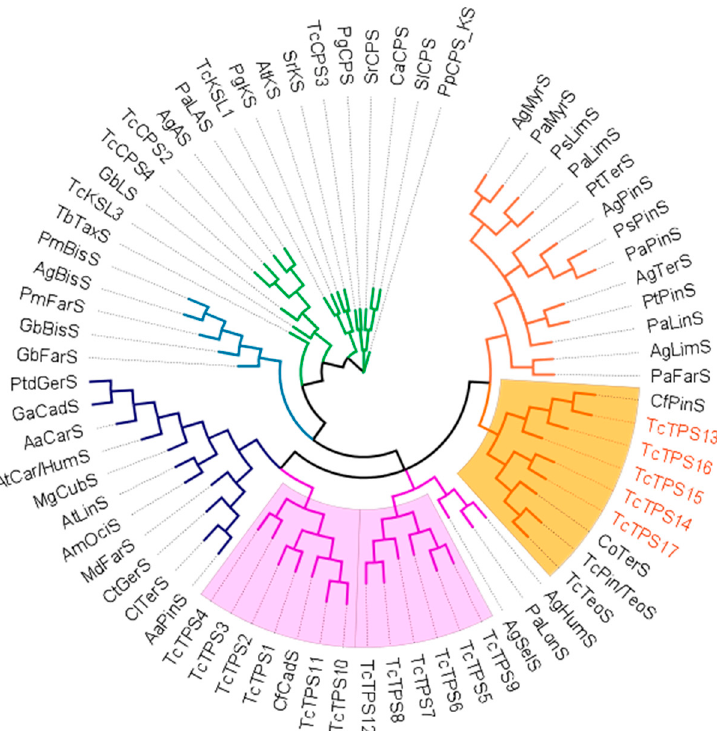
Figure 2. Phylogenetic analysis of selected terpene synthases. Each branch was colored according to its function and species orientation. Green: diterpene synthases; blue: tri-domain sesquiterpene from gymnosperms, deep blue: mono-/sesquiterpene synthases from angiosperms; pink: sesquiter- pene from gymnosperms; orange: monoterpene synthases from gymnosperms. The Cupressaceae- associated subgroups are marked with a colored background.